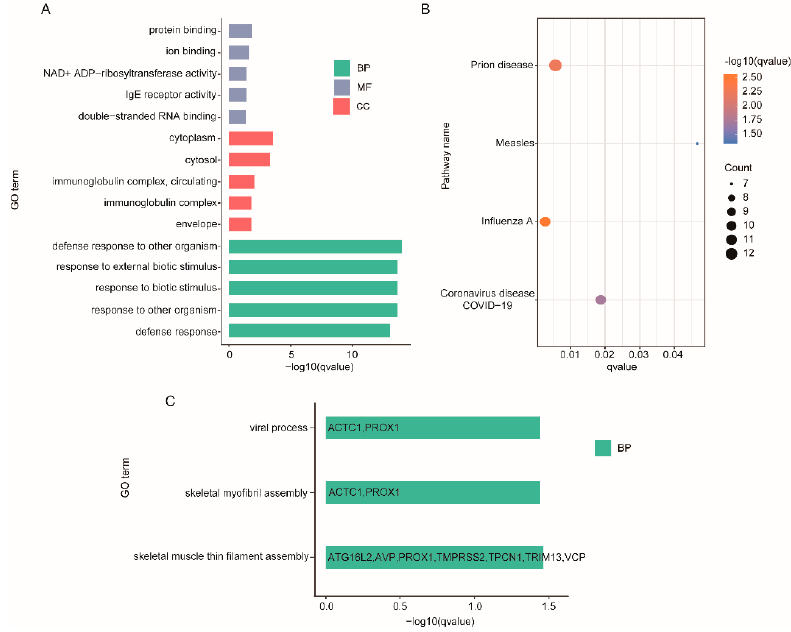
Figure 4. Enrichment analysis of DEGs and DELs. ( A ) The 15 most enriched GO terms in different classes of DEGs. ( B ) KEGG pathways of DEGs. ( C ) GO terms of DELs.